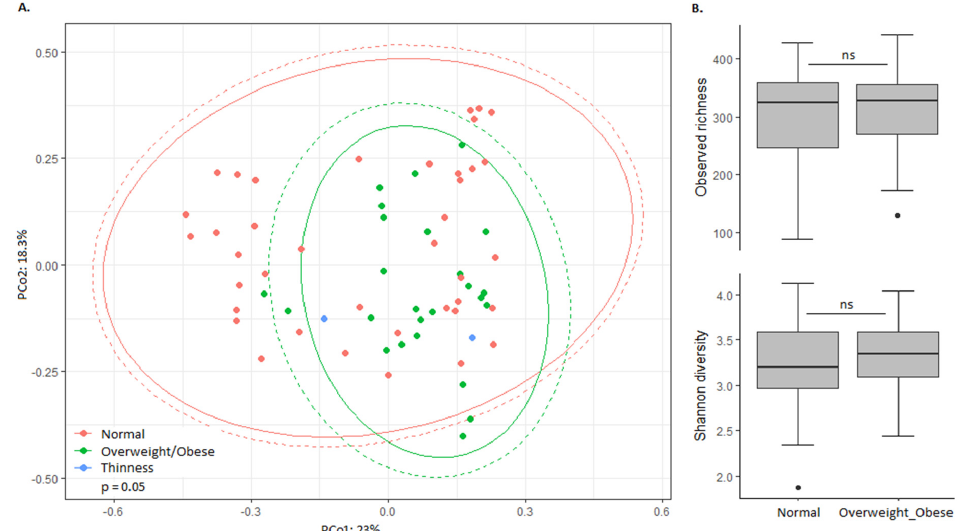
Figure 2. Association between the bacterial gut microbiota and nutritional status in high SES children. ( a ) The Bray–Curtis dissimilarity-based principal coordinate analysis plot labelled according to nutritional status. Ellipses indicate confidence assuming a multivariate t-distribution (solid line) or a multivariate normal distribution (dotted line). ( b ) Alpha diversity in high SES children with normal weight and overweight/obesity. Boxplots show the median, 25th and 75th percentiles, and minimal and maximal values with the exception of outliers (black circles).